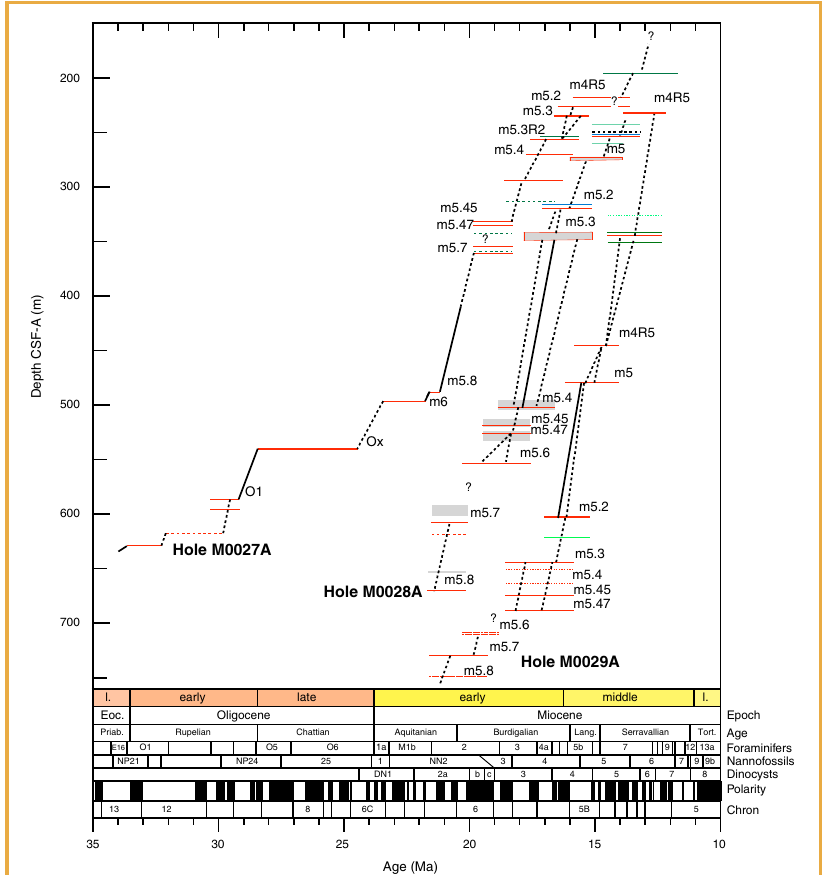
Figure 6. Expedition 313 chronology based on integrating biostratigraphy and Sr isotopic ages obtained at Sites M0027–M0029. Planktonic foraminifera M zone from Berggren et al. (1995), planktonic foraminifera E and O zones from Berggren and Pearson (2005), nannofossil zones from Martini (1971), and dinocyst zones from de Verteuil and Norris (1996). Geomagnetic polarity timescale from Cande and Kent